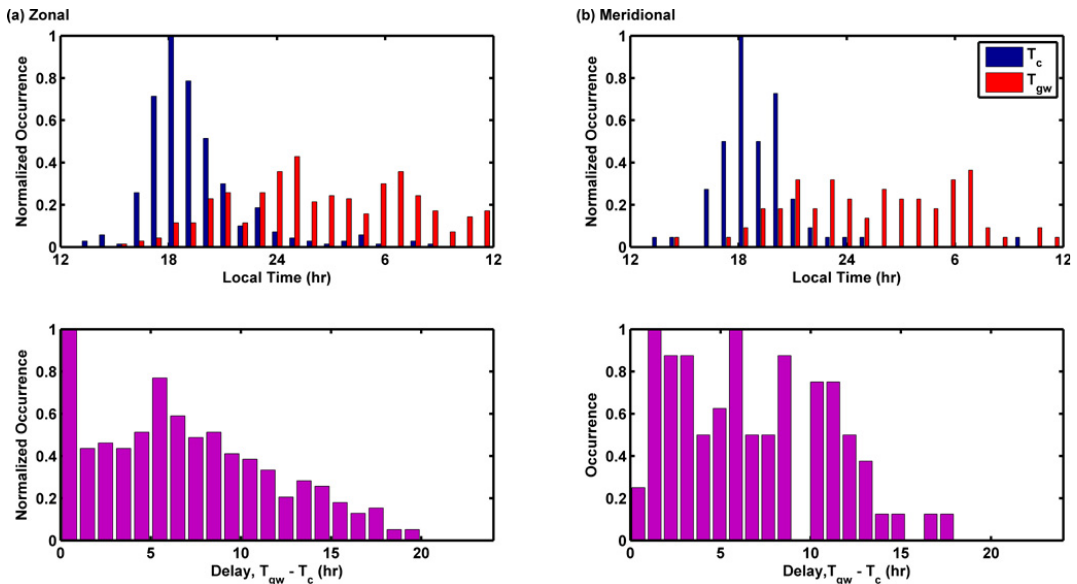
Fig. 4. Time of peak convective activity ( T c ) and time of peak of GW variance ( T gw ) (top panels) and difference between the T gw and T c (bottom panels) for (a) zonal and (b) meridional components,